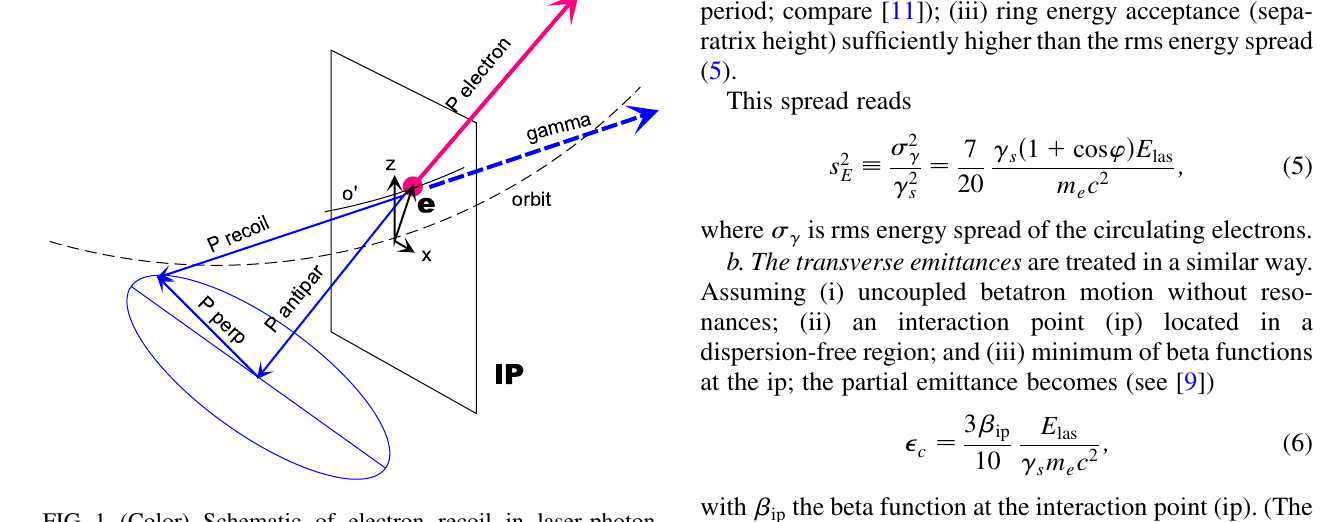
FIG. 1. (Color) Schematic of electron recoil in laser-photon Compton